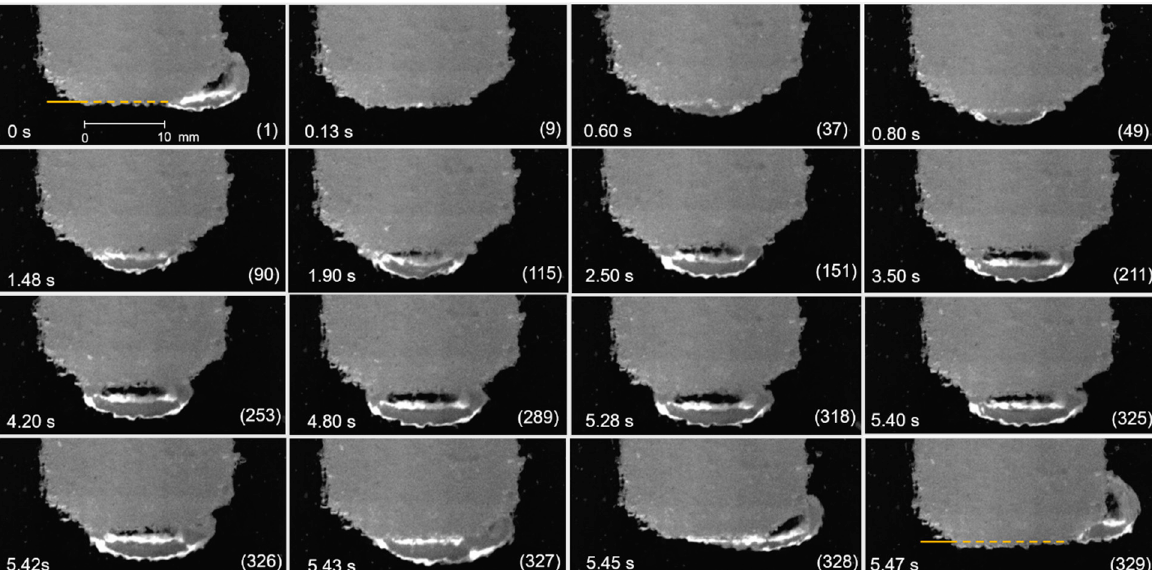
Figure 7. Cycle of one bubble at the horizontal surface during electrolysis at a constant cell voltage of 1.5 V with an average current density of 0.4 A cm − 2 . Each individual image represents one frame with the corresponding number. The frame rate was 60 fps. The frame number is given in the brackets. Frame (1) is defined as 0 s and shows the situation right after a large bubble from the previous bubble cycle is detached from the anode surface. The horizontal yellow line in frames (1) and (329) represents the position of the carbon anode surface. A scale bar is shown in frame (1).